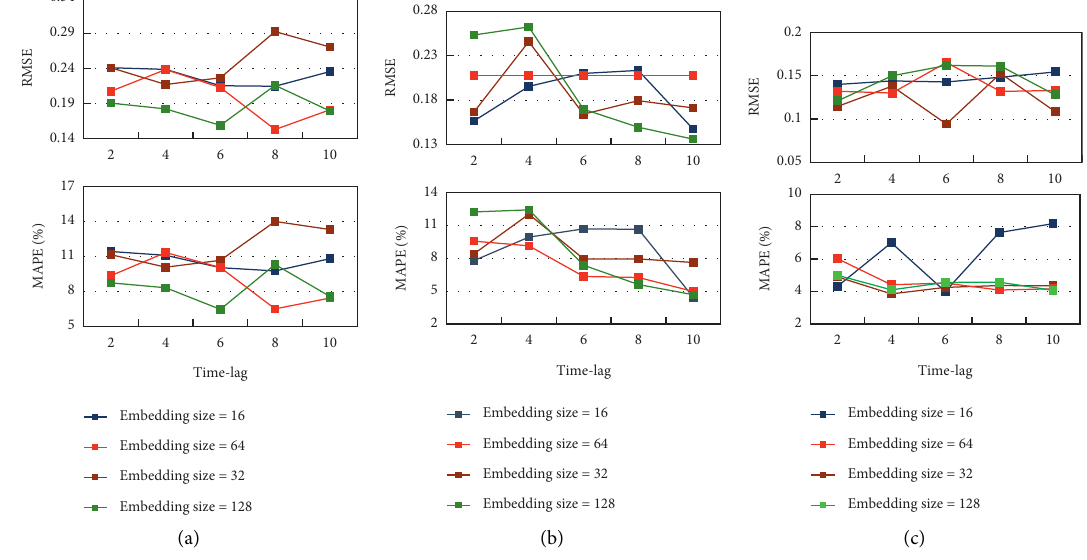
Figure 6: Key parameter sensitivity analysis for LSTM-RF under three time scales: (a) daily, (b) weekly, and (c) monthly CBCFI